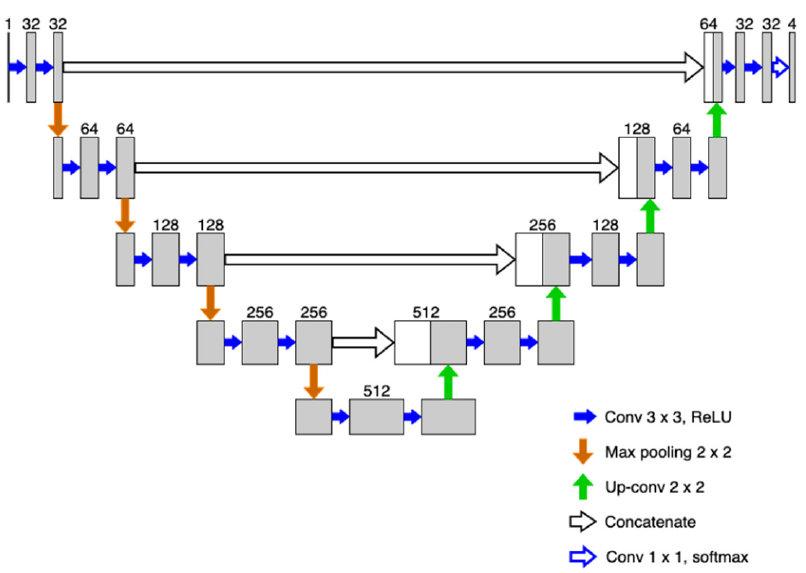
Figure 3. Architecture of a Generator Network with the number of channels indicated at the top of each convolution.